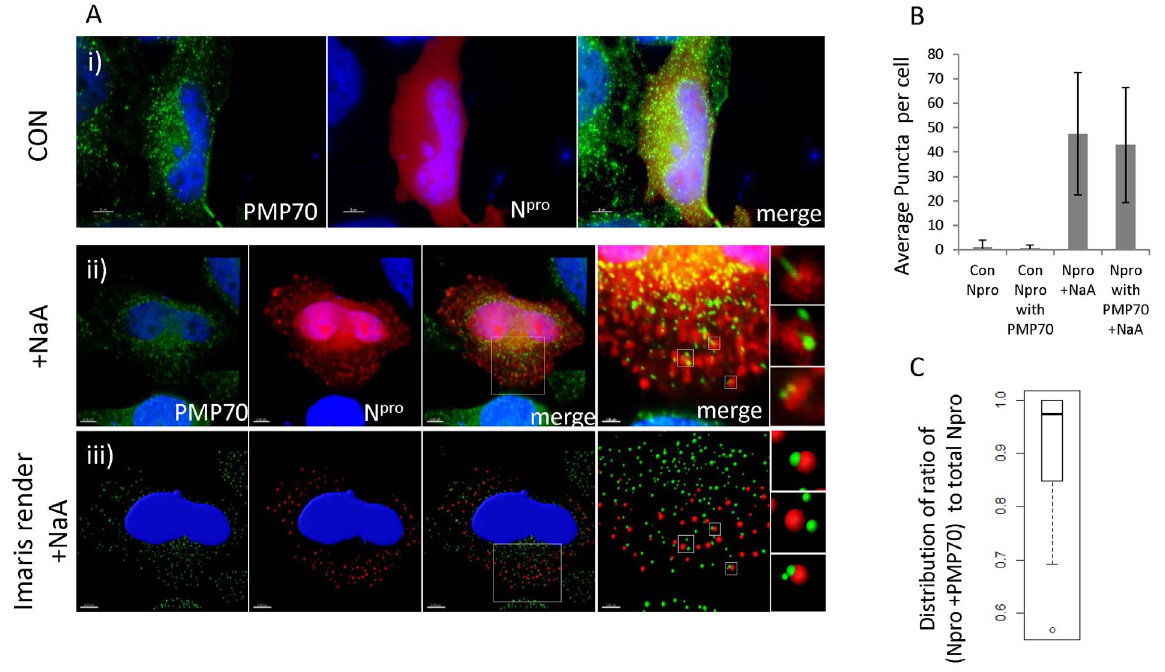
Figure 4. N pro co-distributes with peroxisomes marker PMP70. (A). Peroxisomes were localized by immunostaining with anti-peroxisome marker PMP70 in MEF cells expressing N pro cherry i) control cells (CON) ii) treatment with sodium arsenate ( + NaA) for 4 hours iii) Digital rendering using Imaris software is shown for the images in ii) (scale bars are 5 um). (B). Statistical analysis of average number of N pro puncta per cell and average number co-distributing with PMP70 after sodium arsenate treatment for 4 hours. (C). Boxplot: distribution of the fraction of N pro distributing with PMP70 compare to total number of N pro granules. A Welch two sample t-test was applied, two-sided, not paired, (assuming that the variances are unequal) and showing t=0.5867, df=25.712, p-value=0.5625 with the lower end of the box=25% of the data, bold line in the middle=median, Upper end of the box=75%, lower whisker=5%. (Fig. 5B: N pro , lanes 3 and 4). Also levels of mutant N pro C112R increased, showing this accumulation was independent of binding to IRF3 (Fig. 5B lanes 5–6). These results demonstrate that peroxisomes are one possible site of IRF3 ubiquitination.